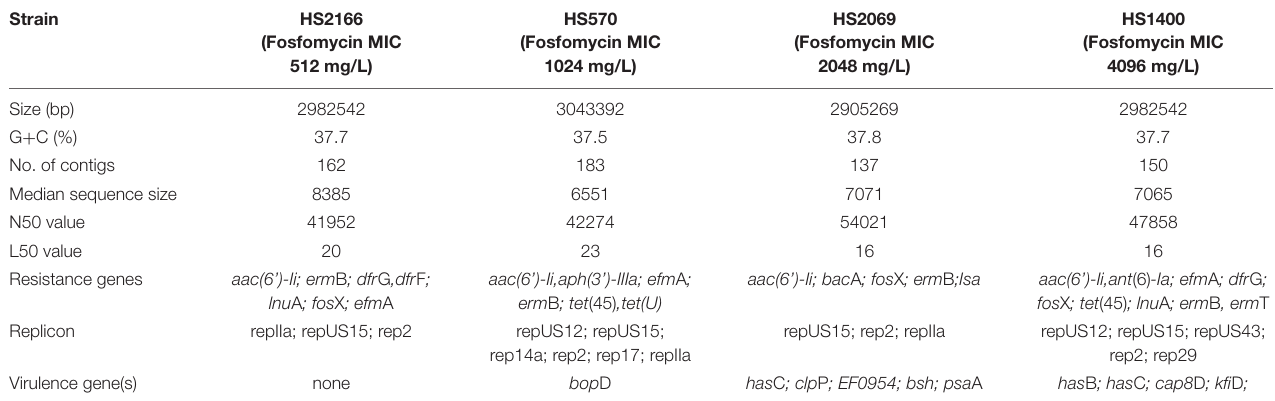
FIGURE 3 | The circle map of HS2069, HS2166, HS570, and HS1440. TABLE 2 | The comparative genome sequences in HS2166, HS570, HS2069, and HS1440